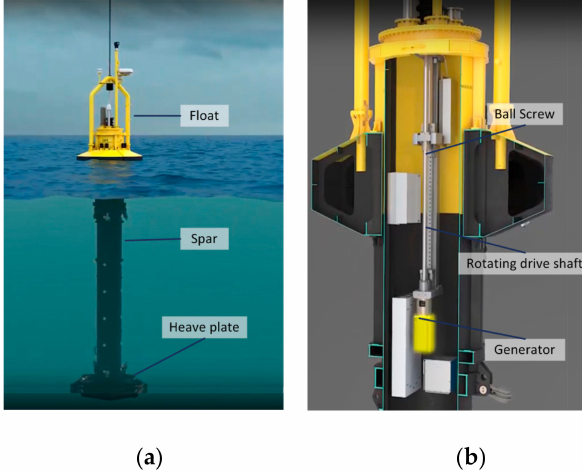
Figure 1. PowerBuoy PB3: ( a ) Overall structure; ( b ) Conversion mechanism. Adapted with permission from Ocean Power Technologies, 2019.